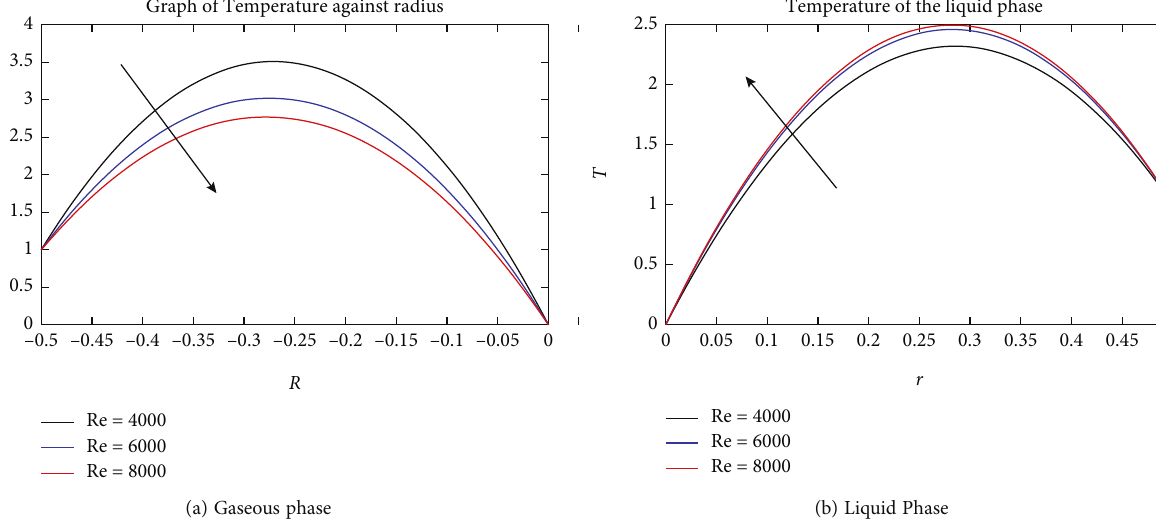
Figure 6: E ff ects R